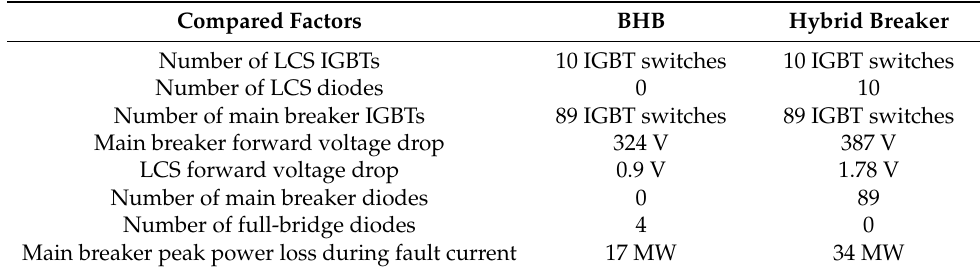
Table 2. Comparison of the BHB and the hybrid breaker.